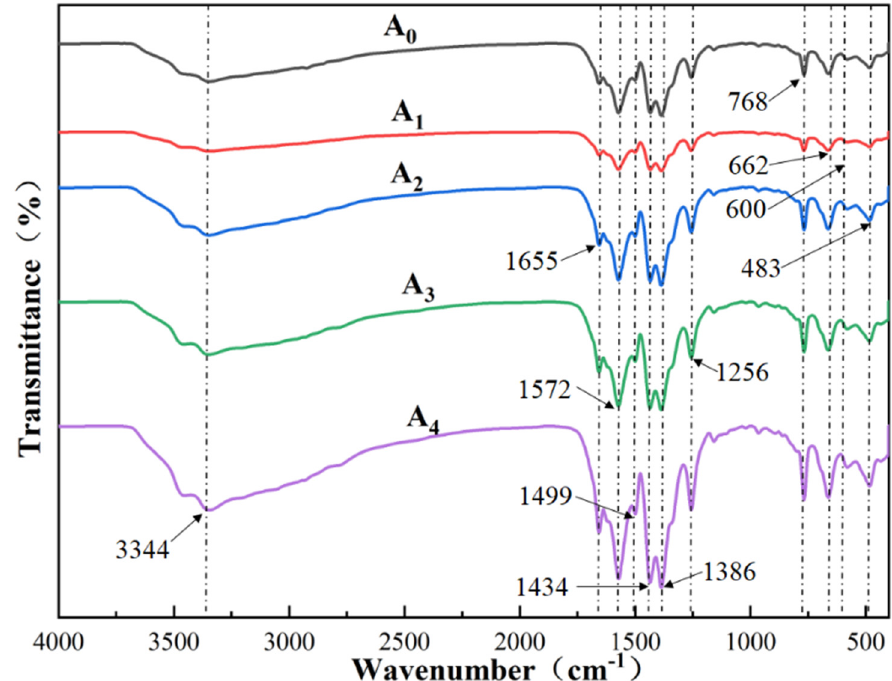
Figure 5. Fourier transform infrared (FT − IR) profiles recorded for UiO − 66 − NH 2 synthesized under conditions of varying silver doping levels.